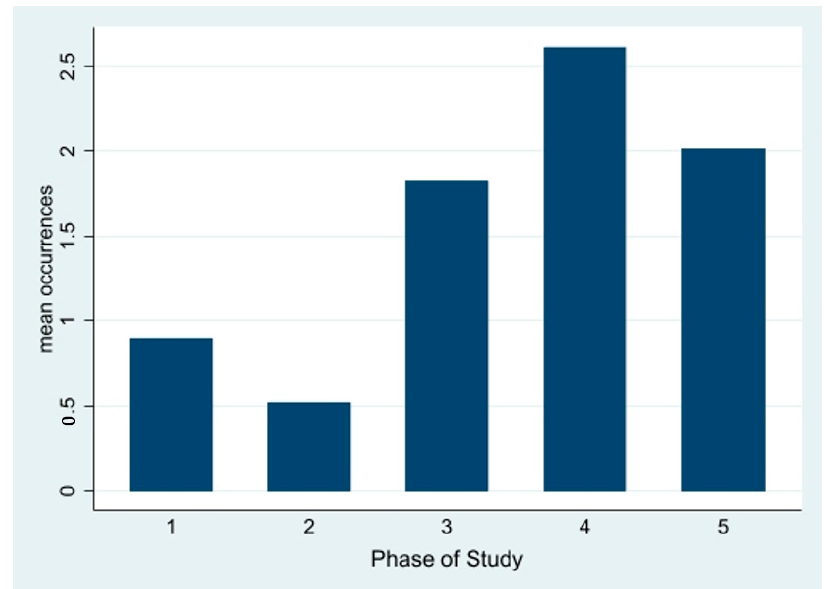
Figure 2. The model developed in statistical testing of bachelor aggression predicts a rise in aggression initiated by HJ, the introduced blackback. Adjusted predictions are shown with 95% confidence intervals. The zoo was closed during study months 5 through 10 and during months 15 through 16. While there is a statistically significant association between zoo closure and lower bachelor aggression, looking at the level of aggression in Figure 3 during each of the two closures separately makes it clear that closure does not cause the reduction in bachelor aggression. Over the course of the 19-month study, the lowest level of bachelor aggression that occurred was during the first closure while the highest level of aggression that occurred was during the second closure.